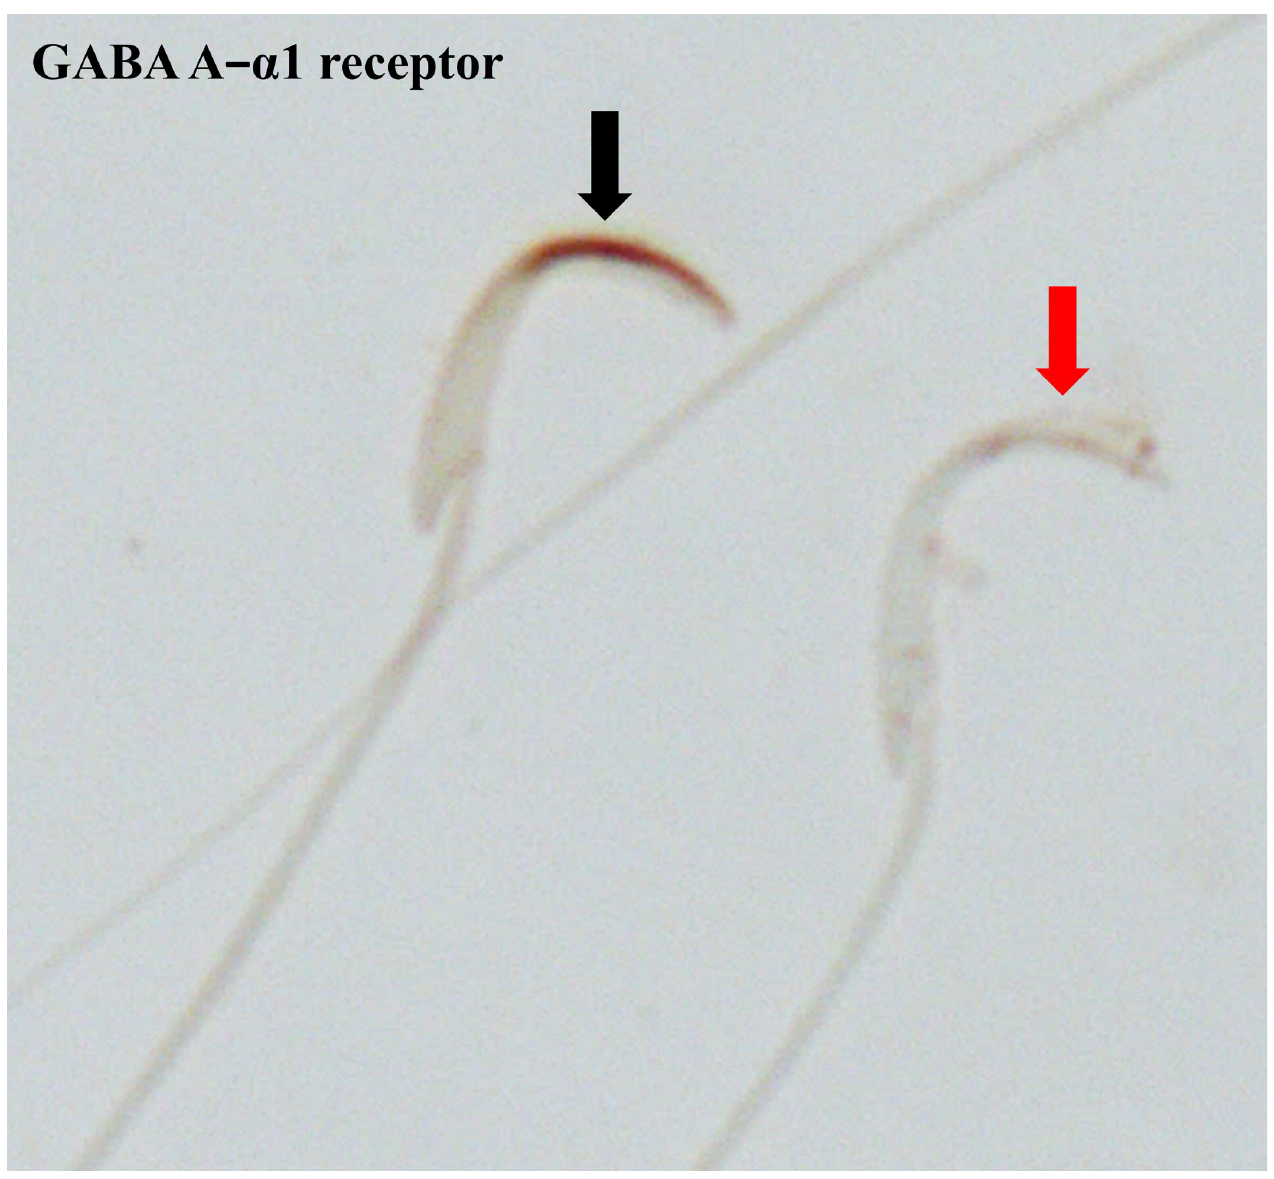
Fig 3. Immunostaining for GABA A- α 1 receptor in rat epididymal spermatozoa at 1000 × magnification. A black arrow indicates an immunopositive spermatozoon, whereas a red arrow indicates an immunonegative spermatozoon.